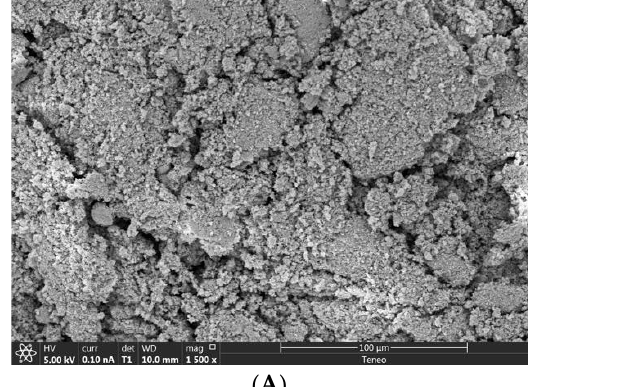
Figure 3. XRD pattern of Bipy-PAN.